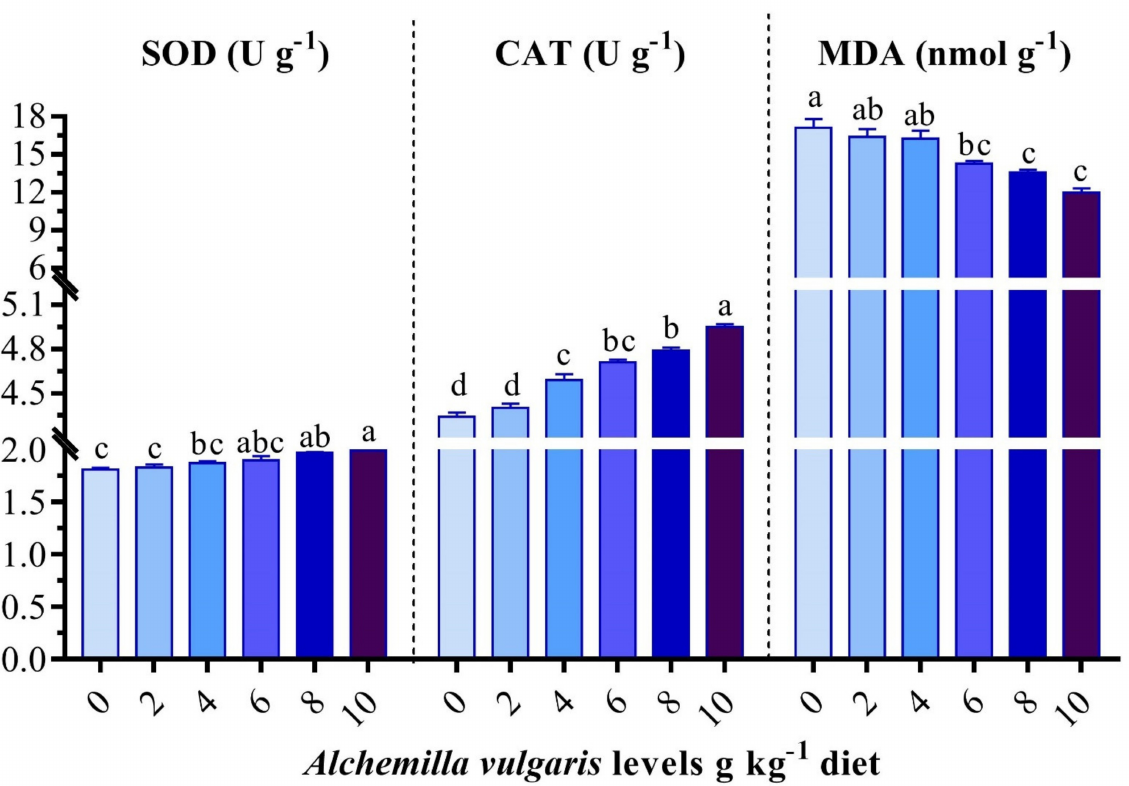
Figure 4. Effect of Alchemilla vulgaris dietary supplementation on antioxidant biomarkers in the liver homogenate of O. niloticus . SOD: superoxide dismutase, CAT: catalase, MDA: malondialdehyde. Columns bearing different letters are significantly different at p < 0.05.